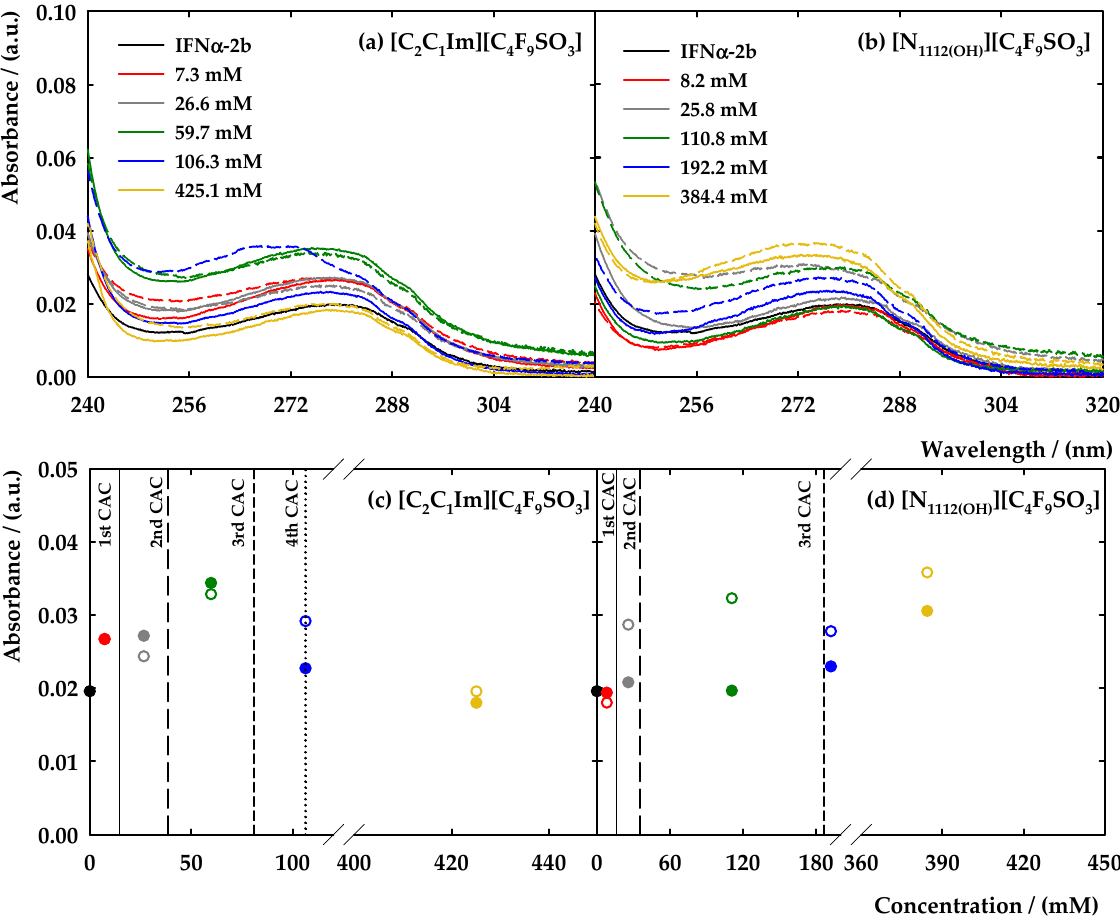
Figure 5. UV–Vis absorption spectra of ( a ) [C 2 C 1 Im][C 4 F 9 SO 3 ] and ( b ) [N 1112(OH) ][C 4 F 9 SO 3 ] with IFN- α 2b at 20 μ g/mL (black solid line) at different concentrations. All samples were prepared in 5 mM NaH 2 PO 4 (pH = 7.4) and measured at 25 °C. In ( c , d ) the variation in the absorbance at 280 nm is represented. The solid lines in ( a , b ) and full symbols in ( c , d ) correspond to the measurements at 0 h. The dashed lines in ( a , b ) and the empty symbols in ( c , d ) correspond to the measurements after 24 h of incubation. The colours of the symbols correspond to the colours of the lines.